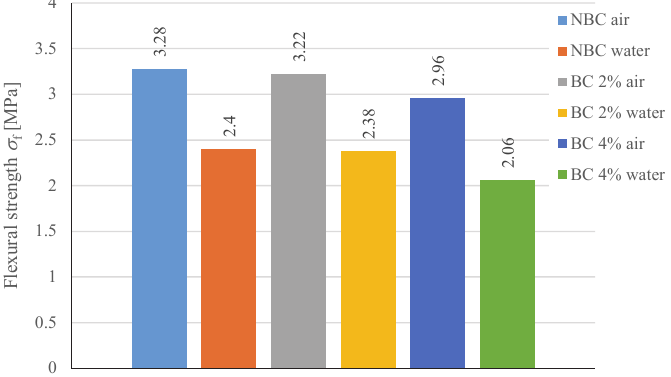
Figure 4: Comparative histograms of average flexural strength of foamed concrete specimens with different curing conditions and biochar